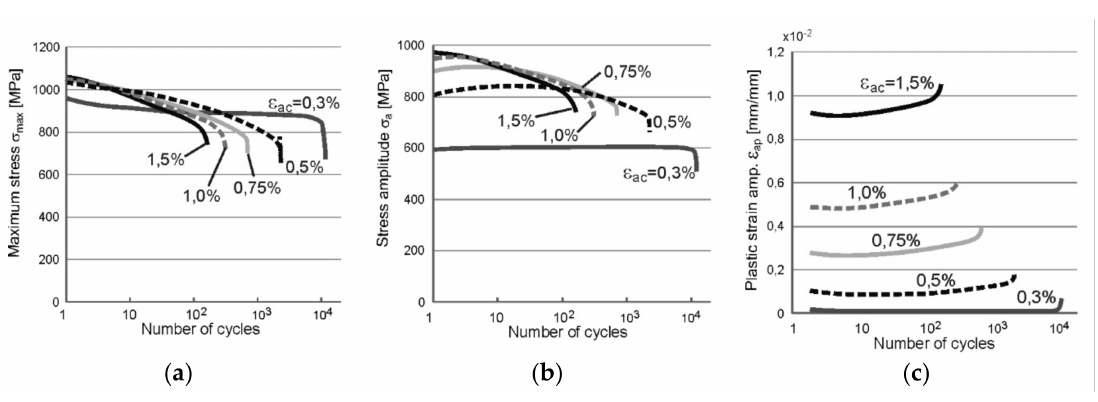
Figure 3. The results of LCF tests recorded for PM as the courses of: ( a ) maximum stress σ max ; ( b ) stress amplitude σ a ; ( c ) amplitude of plastic strain component ε ap .